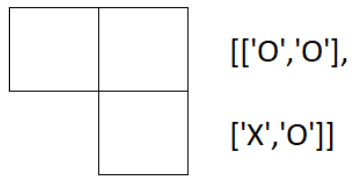
Figure 3. A possible building form and data structure of 3 basic units.